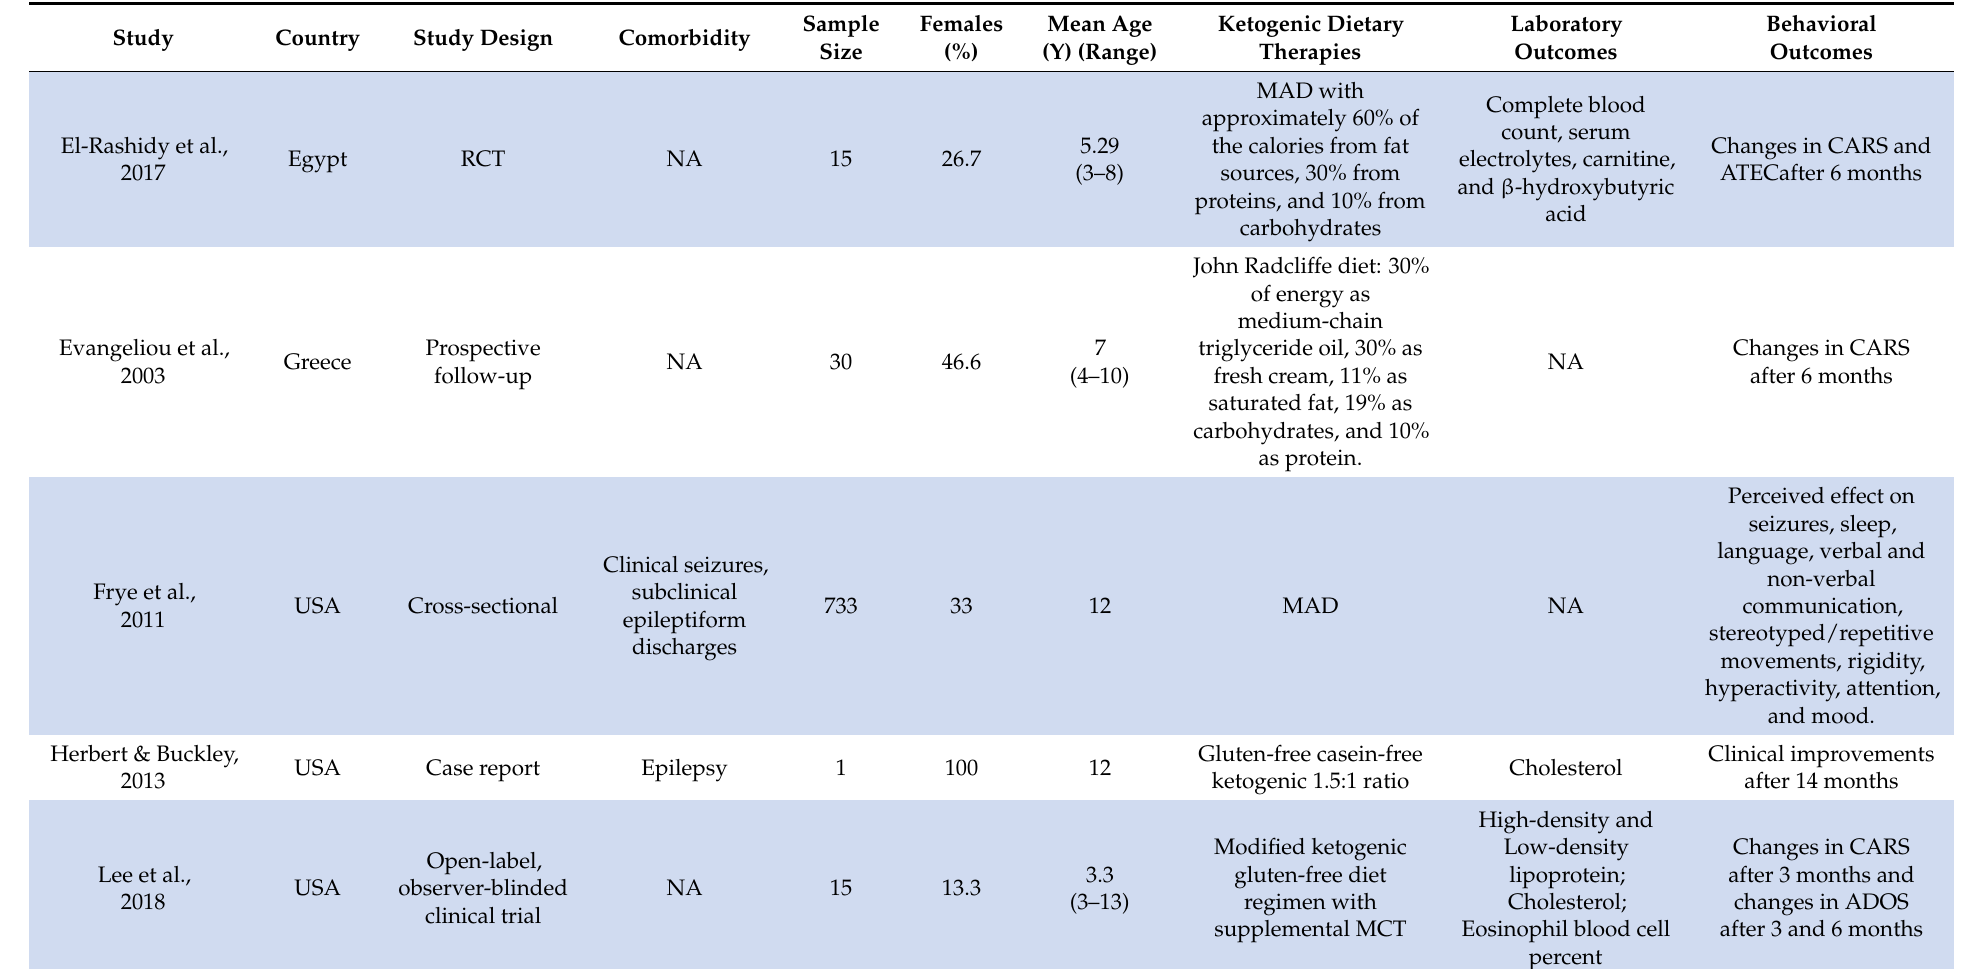
Table 1. Characteristics of included studies. Abbreviations: Y, year; NA, not available; ADHD, attention-deficit/hyperactivity disorder; RCT, randomized controlled trial; MAD, modified Atkins diet; MCT, medium-chain triglyceride; CKD, classic ketogenic diet; LGIT, low-glycemic index therapy; CARS, childhood autism rating scale; ATEC, autism treatment evaluation checklist; ADOS, autism diagnostic observation